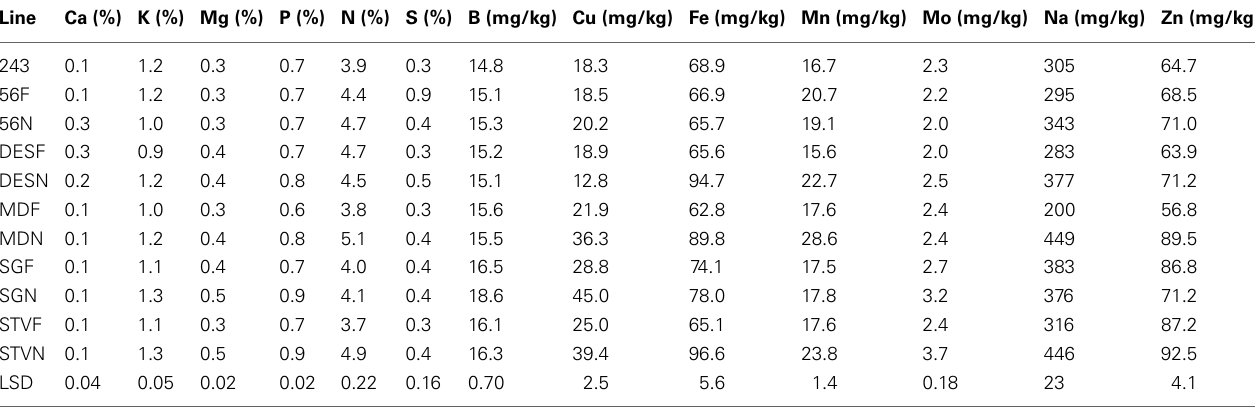
Table 5 | Characterization of cottonseed nutrients composition as influenced by fuzz (F) and fuzzless (N) seed trait in cotton isogenic mutant lines under well watered conditions ∗ .